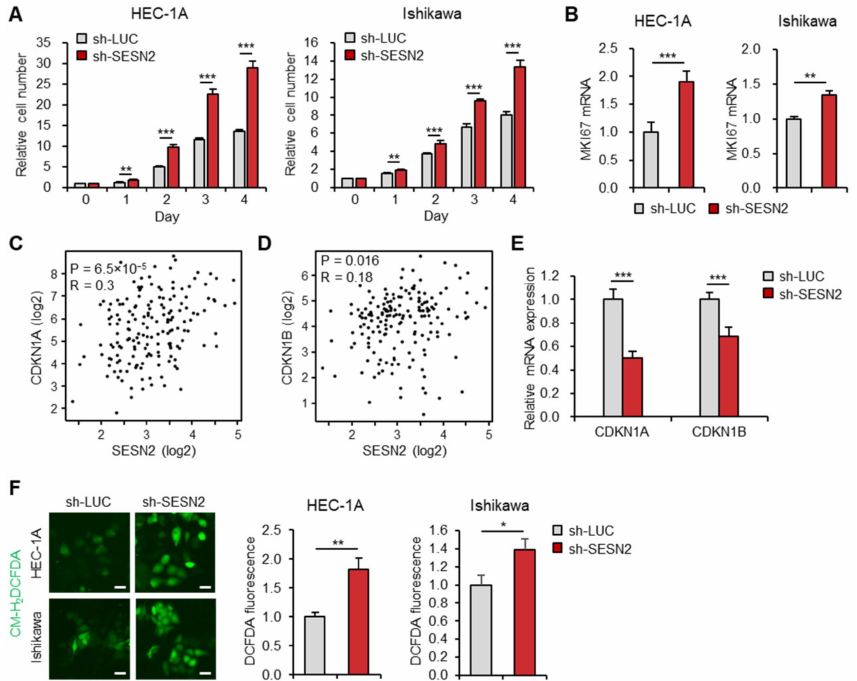
Figure 3. Knockdown of SESN2 promotes proliferation and ROS production in endometrial cancer cells. ( A ) Cell proliferation analysis in HEC-1A and Ishikawa cells infected with lentiviruses expressing shRNAs targeting luciferase (sh- LUC ) or SESN2 (sh- SESN2 ). ( B ) qRT-PCR analysis of MKI67 mRNA levels in HEC-1A and Ishikawa cells infected with sh- LUC or sh- SESN2 lentivirus. ( C , D ) Correlation between expression of SESN2 and cell cycle inhibitor genes CDKN1A ( C ) and CDKN1B ( D ) in endometrial cancer analyzed using the GEPIA database. The correlation coe ffi cients were calculated using Spearman’s test. ( E ) Relative mRNA expression of CDKN1A and CDKN1B in HEC-1A cells infected with sh- LUC or sh- SESN2 lentivirus. ( F ) Intracellular ROS levels were analyzed by the CM-H 2 DCFDA probe in HEC-1A and Ishikawa cells infected with sh- LUC or sh- SESN2 lentivirus. Data are shown as mean ± SEM. Results are representative of at least three independent experiments. * p < 0.05; ** p < 0.01; *** p < 0.001 (Student’s t